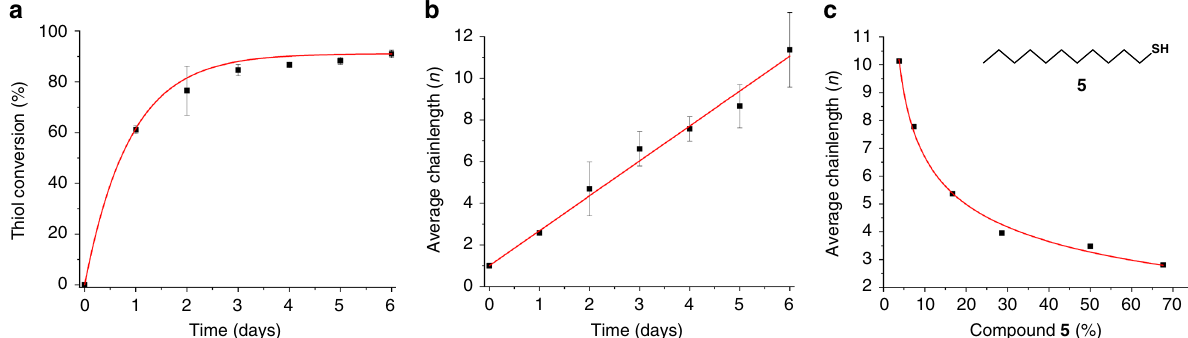
Fig. 3 Growth of disul fi de polymers. a The molecular assembler drives the conversion of thiol ( 2 ) into disul fi de polymers. Numbers were obtained using NMR analysis of the produced polymers and were further con fi rmed using gel permeation chromatography (GPC). b Based on the conversion of thiol to disul fi de, the average chainlength of the produced polymers can be calculated. c Average polymer length after 6 days of polymerization in the presence of 1-dodecanethiol ( 5 ). The amount of 1-dodecanethiol (which acts by capping the growing polymers, stopping further chain elongation) as percentage of the total thiol amount is given on the x axis. Error bars represent the standard deviation. Source data are provided as a Source Data fi